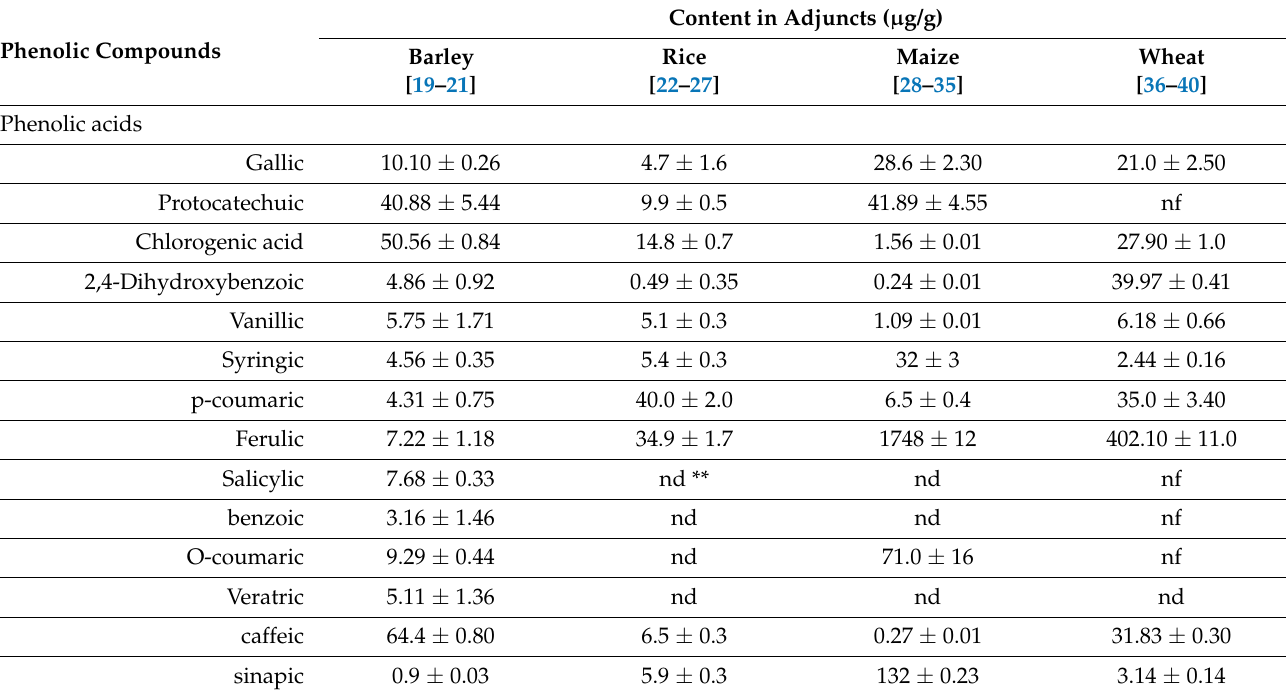
Table 1. Phenolic compounds of native